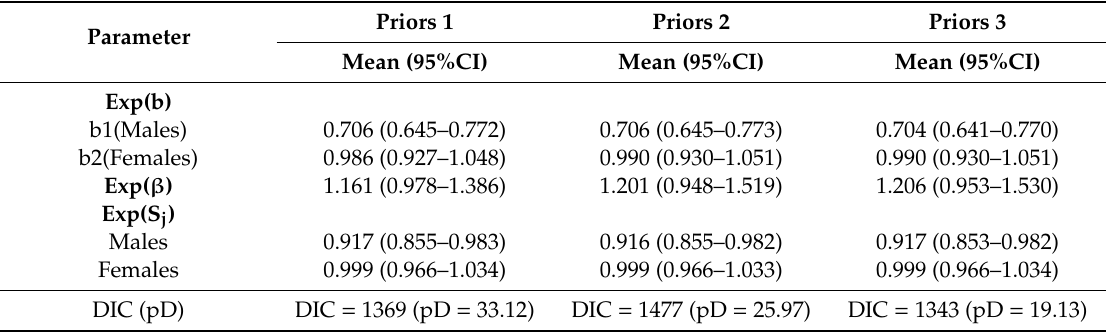
Table 3. Sensitivity analysis with respect to precision parameter τ